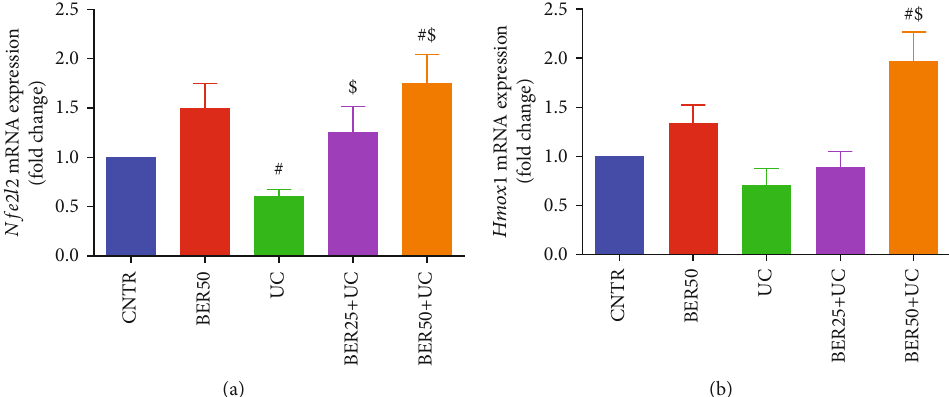
Figure 5: E ff ect of berberine at di ff erent doses on (a) Nfe2l2 and (b) Hmox1 mRNA expression in colonic tissue of experimental colitis in rats. The results are expressed as the mean ± SD ( n = 7 ). qRT-PCR results were normalized with Gapdh and represented as fold change as compared to mRNA levels in the CNTR rats. # p < 0 : 05 compared to the CNTR group (intact group); $ p < 0 : 05 compared to UC-untreated